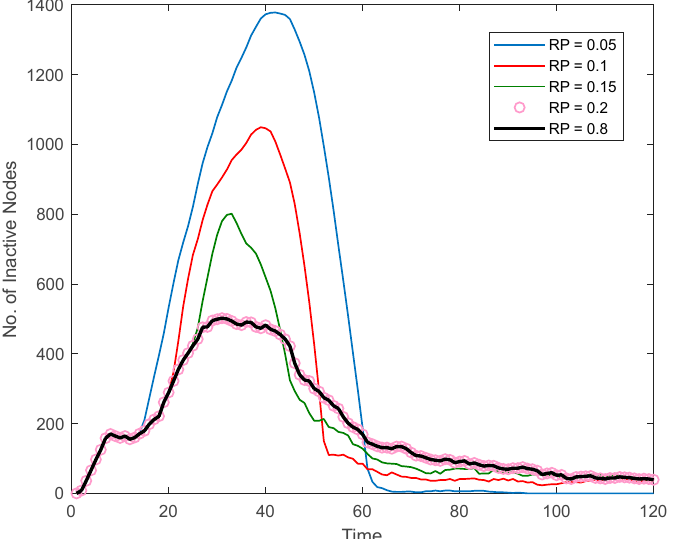
Figure 7. The number of inactive nodes as a function of time under load-based failures with different recovery potentials. In all cases, α = 1, T = 0.05, P = 0.01, number of initial attack nodes = 8.